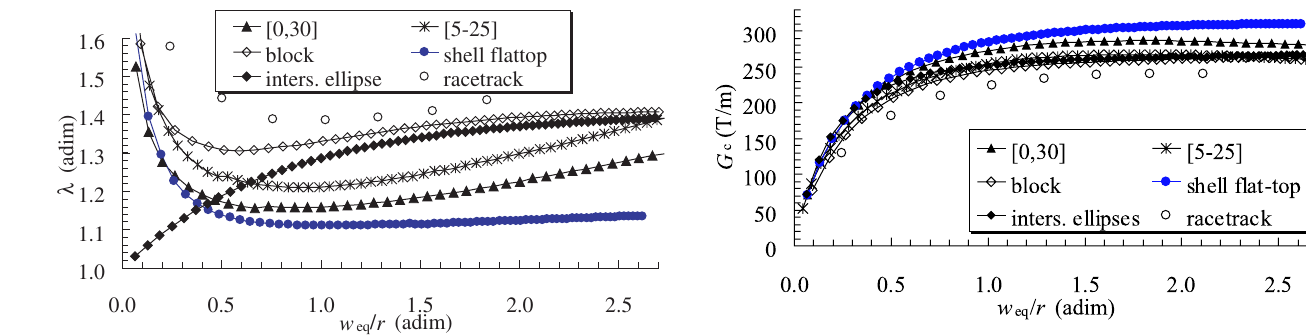
FIG. 22. (Color) Numerical evaluation of the critical gradient versus equivalent sector width (41) in six coil layouts with an aperture radius of 30 mm ( (cid:3) (cid:2) 0 : 28 ).